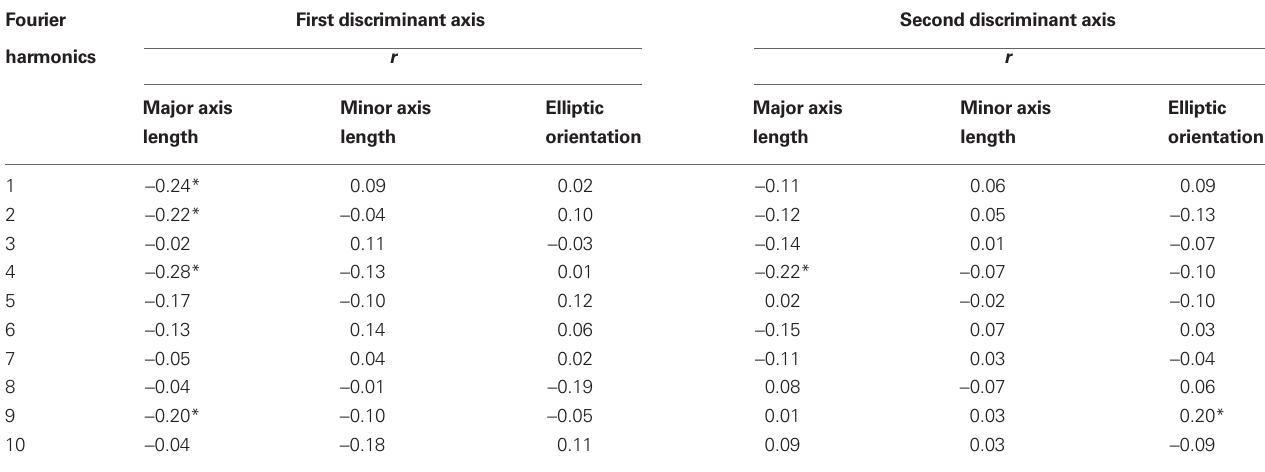
Table 3 | Discriminant analysis of the elliptical Fourier descriptors in WT, Eda Ta/Y , and Eda Ta/ + mice: correlations between the elliptical Fourier descriptors and the first two discriminant